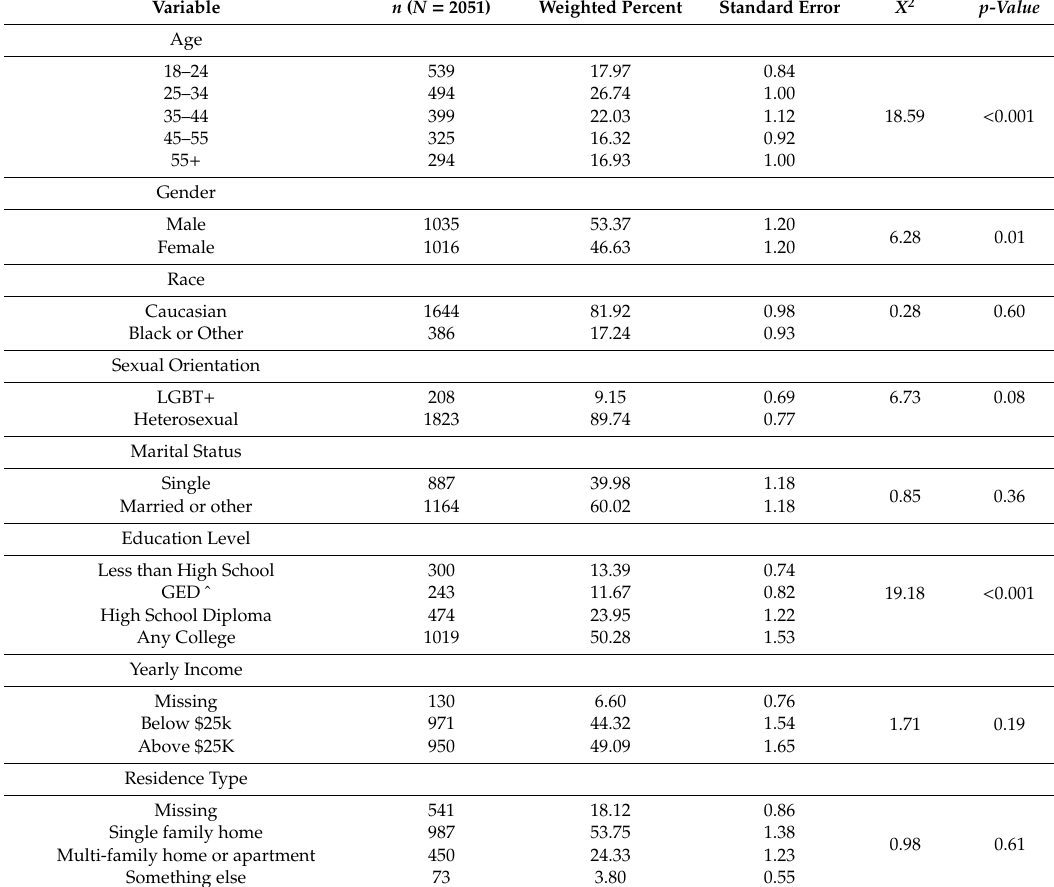
Table 1. Distribution of sociodemographic and behavioral characteristics among dual users. Variable n ( N = 2051) Weighted Percent Standard Error X 2